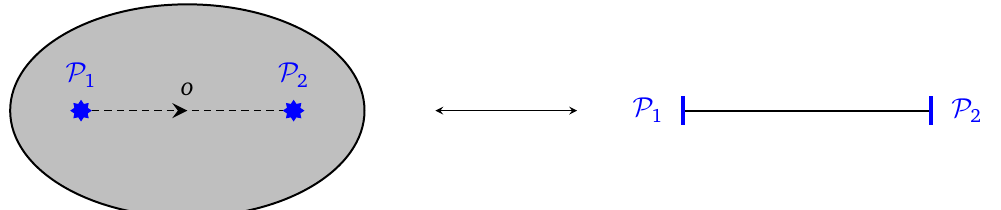
Figure 5: Compactifying 6 d N = ( 2,0 ) theory of type g on a sphere-like surface with an o -twisted puncture P and o − 1 -twisted puncture is equivalent to compactifying 5 d 1 N = 2 SYM theory with gauge algebra h ∨ on an interval with boundary conditions o associated to P and P inserted at the two ends of the 1 2